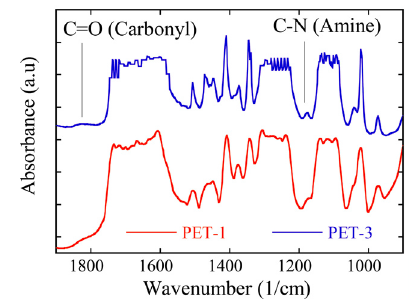
Table 2. Identification of functional groups in PET-1. *Bands of PET polymer cited from reference 15. Wavelength (cm -1 )